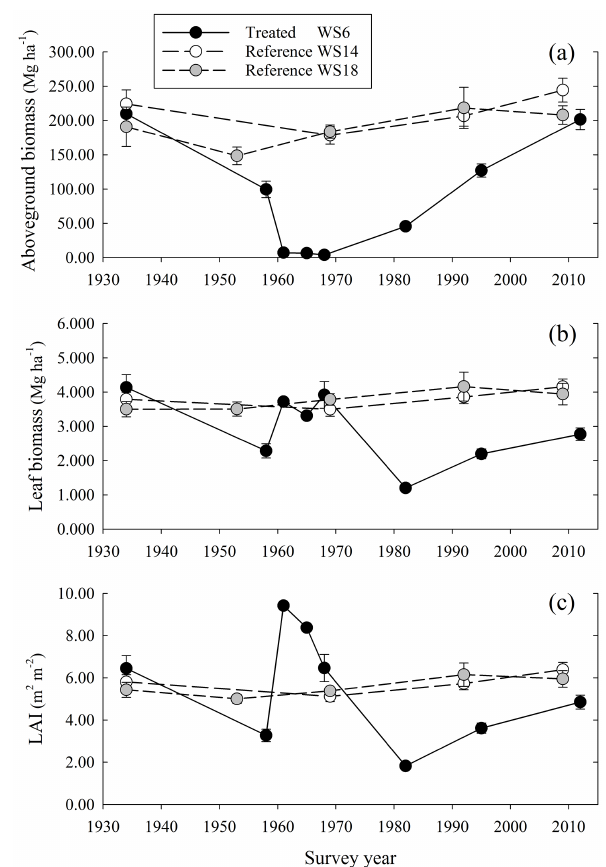
Figure 2. Mean ( ± SE bars) (a) aboveground biomass, (b) leaf biomass, and (c) leaf area index (LAI) for the treated WS6 and ref- erence (WS14, WS18) watersheds over